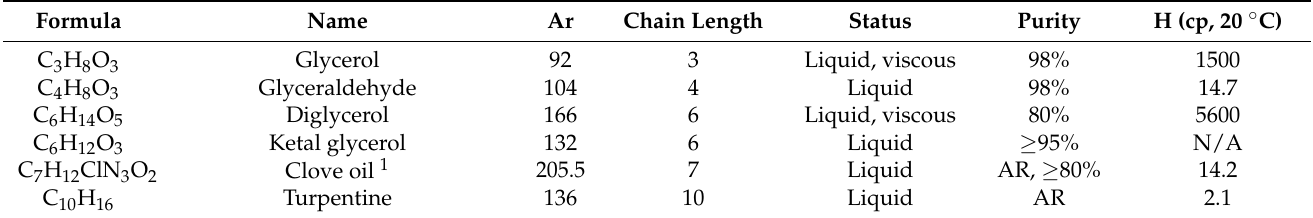
Table 2. Oils and fats used for sample